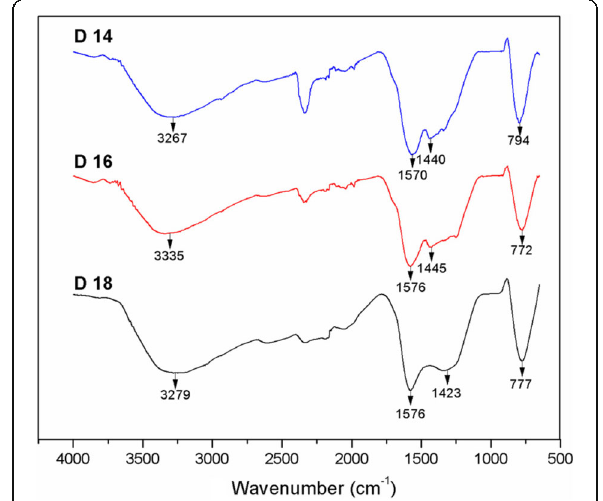
Fig. 6 The IR spectrum for the TiO 2 -CNF sample with different DTC parameter at the range of 650 to 4000 cm − 1